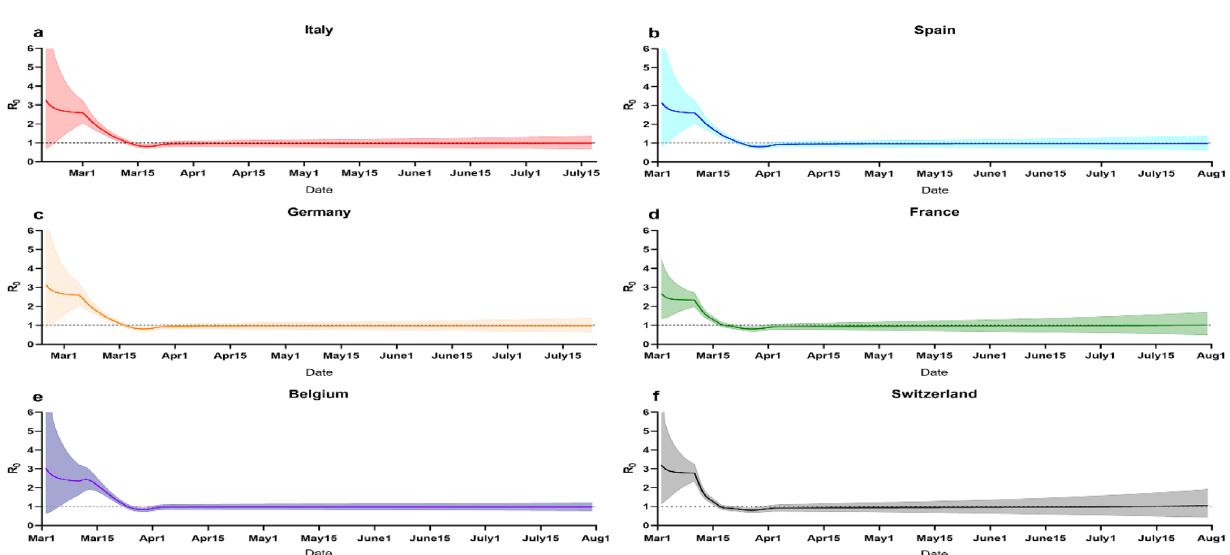
Figure 4. Illustration change of reproduction number R in 6 European countries (Italy, Spain, Germany, France, Belgium and Switzerland) by implementing suppression